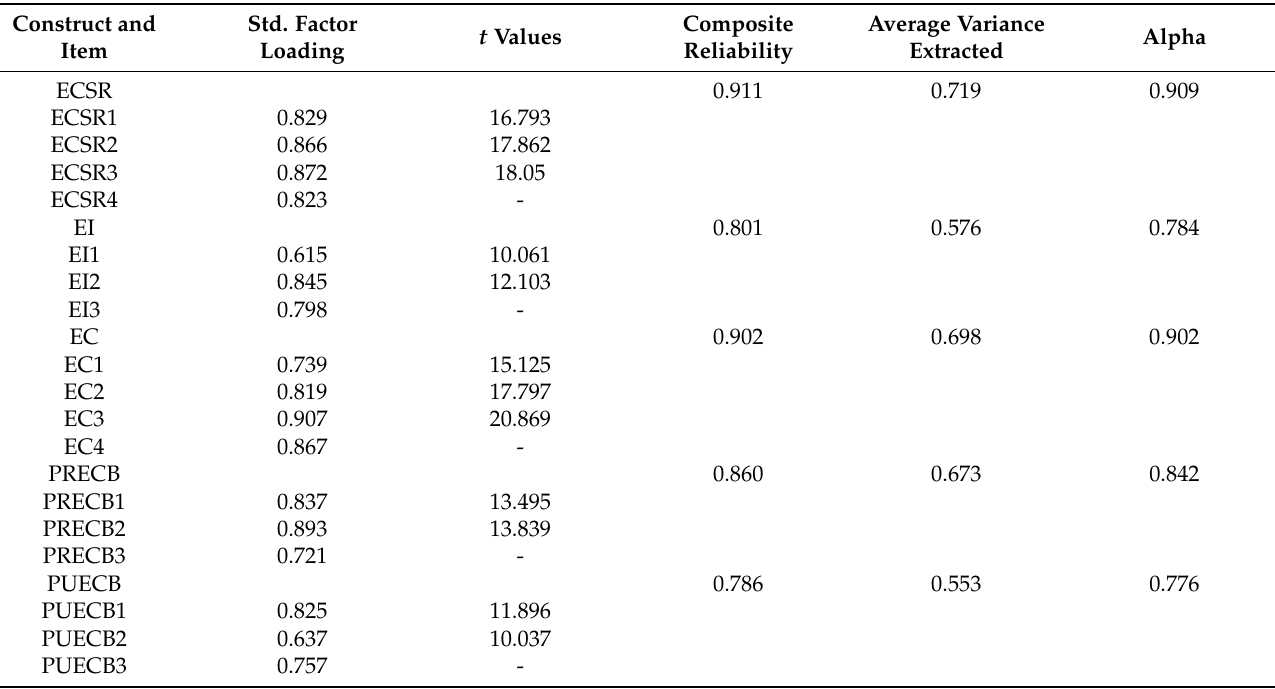
Table 2. Assessment of measurement model.